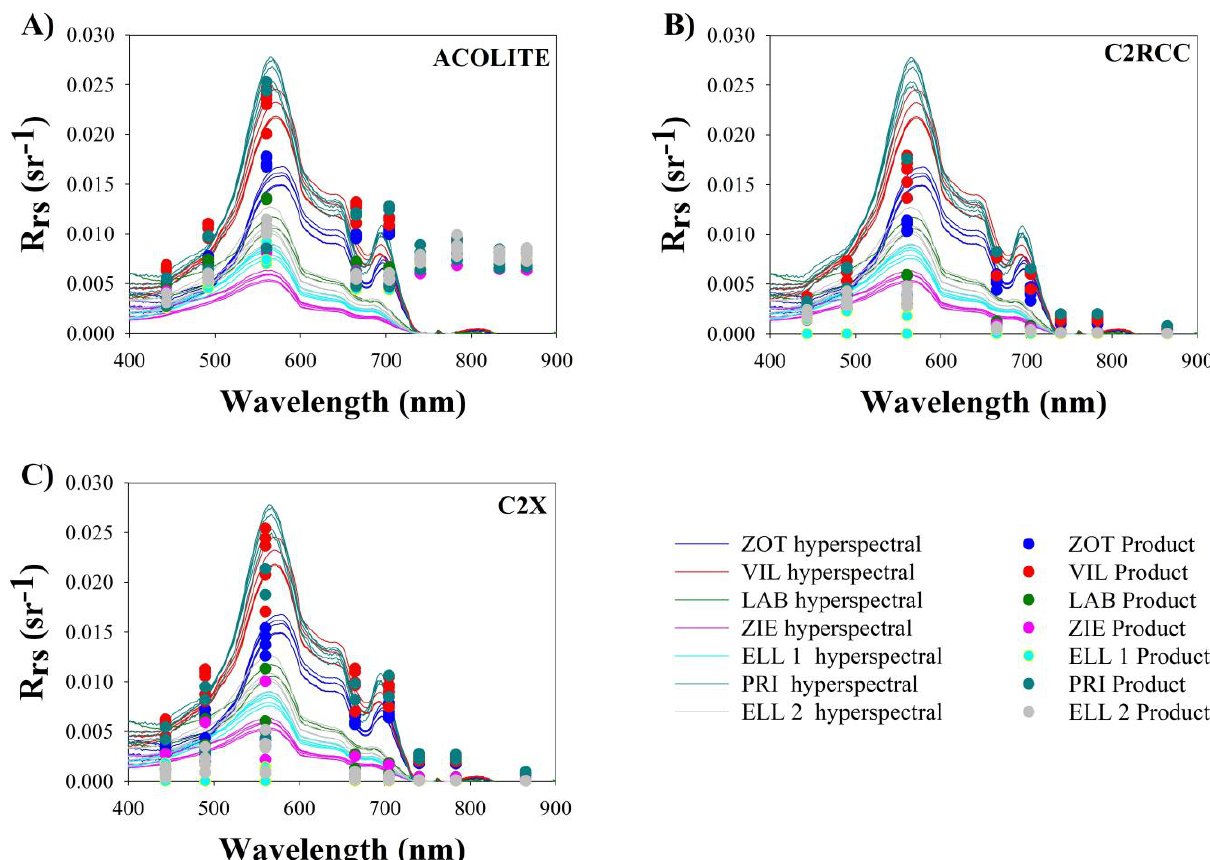
Figure A1. Comparison between R rs spectral from proximal hyperspectral data (solid lines) and the best atmospheric correction routines for Sentinel-2/MSI (points). ( A ) ACOLITE , ( B ) C2RCC , ( C ) C2X .